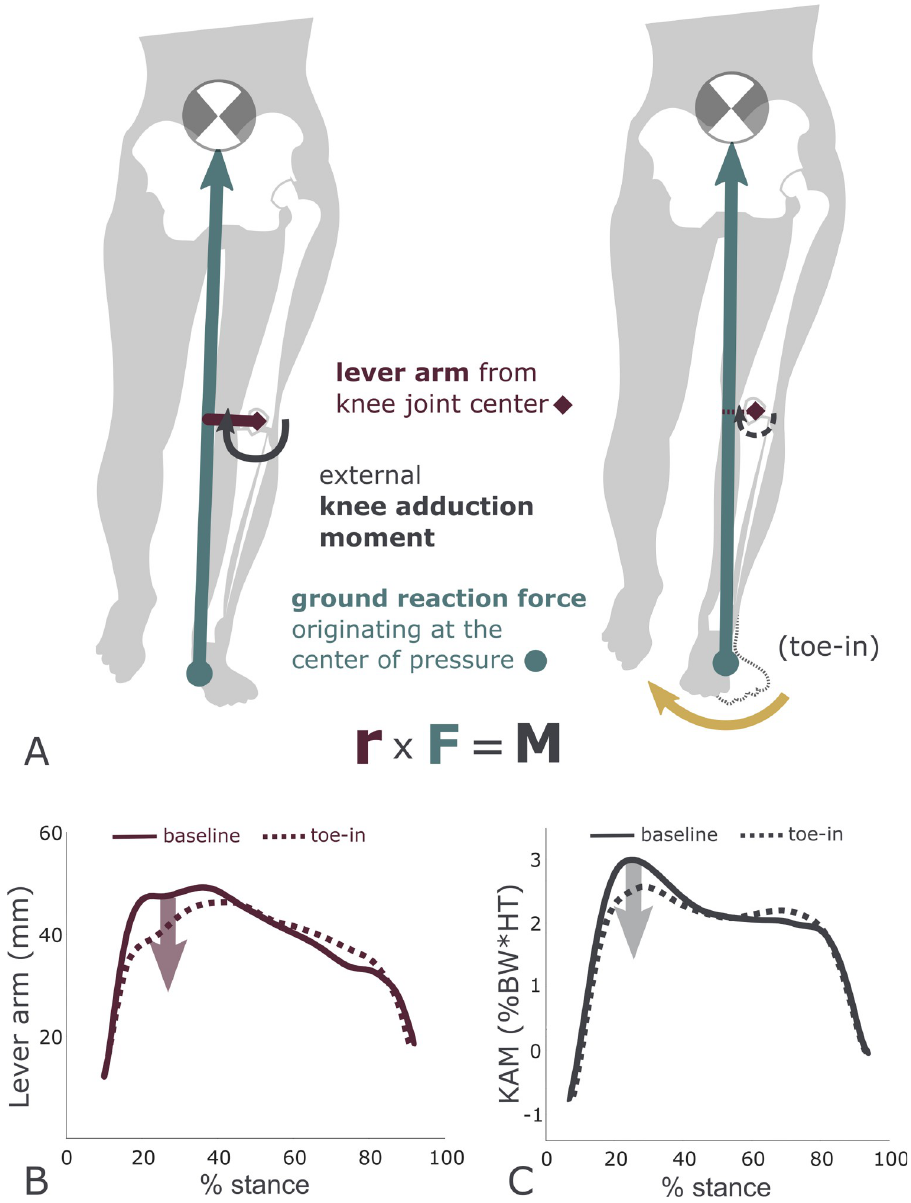
Fig 1. Toe-in gait reduces the knee adduction moment. (A) The external moment about the knee is computed using the ground reaction force and lever arm from the knee joint center. Toe-in gait shifts the knee joint center medially and the foot center of pressure laterally in the first half of stance, reducing the KAM. Group average data [18] illustrate how (B) toe-in gait shortens the lever arm and (C) reduces the KAM. Ground reaction force magnitude (not shown in the figure) does not